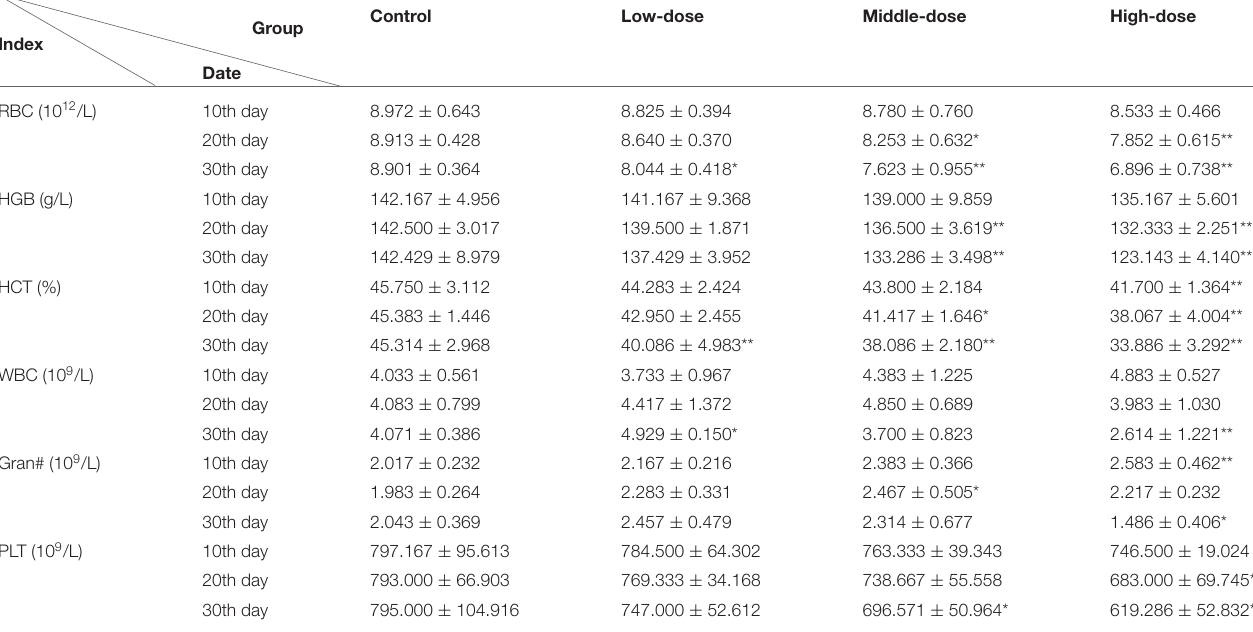
n = 10, the data in table are M ± SD, means with no mark in the same row differ insignificantly (p > 0.05); while with “ * ” differ significantly (p < 0.05) with “ ** ” differ extremely significant.